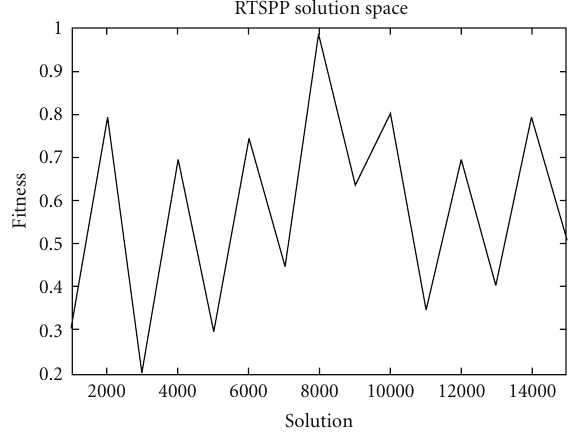
Figure 1: A hypothetical solution space.